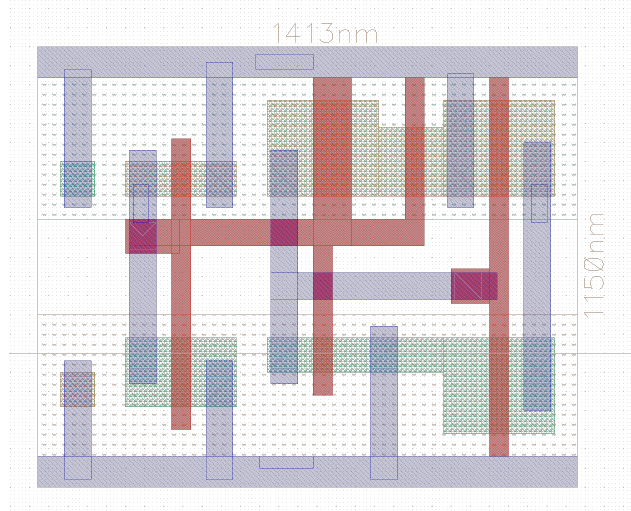
Figure 6. layout of the proposed sensor